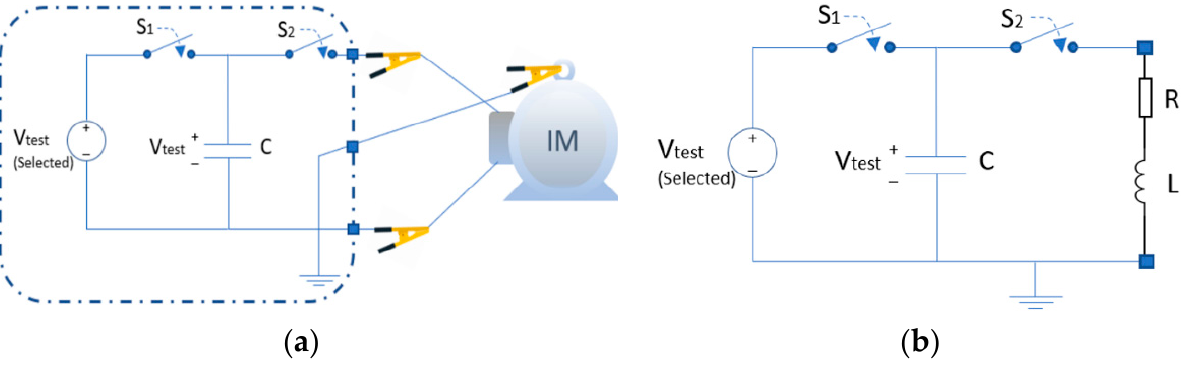
Figure 1. Surge comparison test circuit. ( a ) Surge test motor connection ( b ) Equivalent circuit.